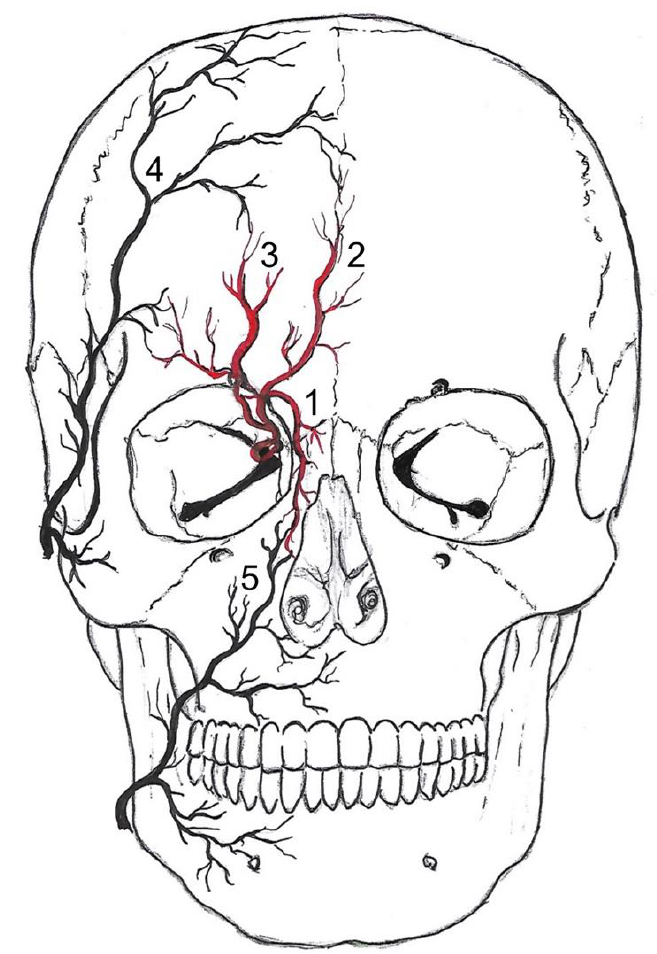
Figure 1. Anastomoses of the internal and external carotid arteries. Vessels drawn in red (1–3) belong to the internal carotid drainage and vessels depicted in black (4, 5) belong to external carotid artery drainage. The dorsal nasal artery (1) and the supratrochlear artery (2) are the terminal branches of the ophthalmic artery—a branch of the internal carotid artery. The supraorbital artery (3) is a branch of the intraorbital ophthalmic artery and passes through the supraorbital foramen. It anastomoses within the scalp with the superficial temporal artery (4) and the supratrochlear artery. The supratrochlear artery pierces the orbital septum at the medial corner of the orbit superiorly. It anastomoses with the superficial temporal artery and the contralateral supratrochlear artery. The dorsal nasal artery pierces the septum orbitale above the medial palpebral ligament. It anastomoses with the angular termination of the facial artery (5) and the contralateral dorsal nasal artery.